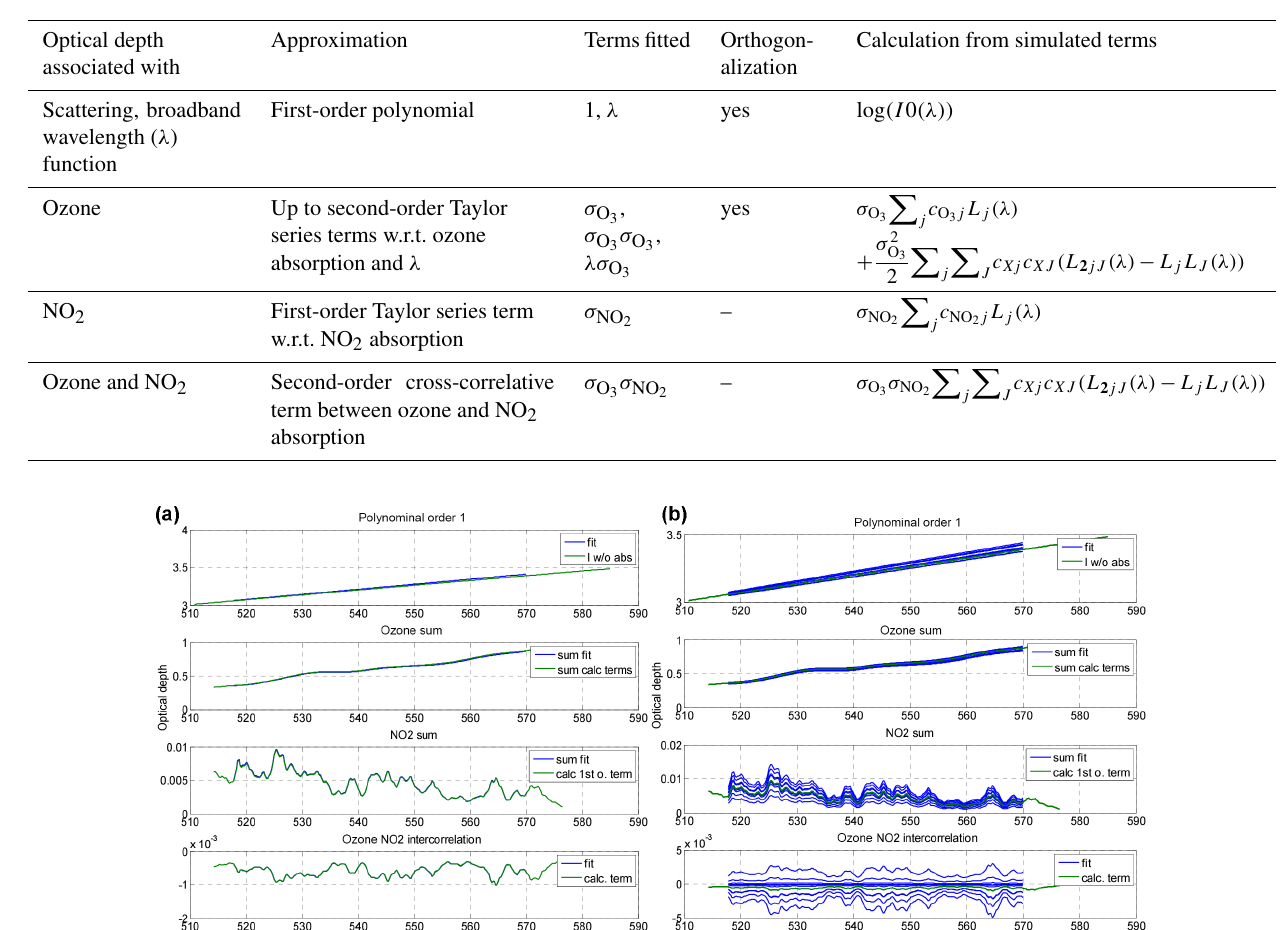
Table 1. Fit parameters included in the DOAS evaluation of synthetic spectra in the spectral range 520–570nm.